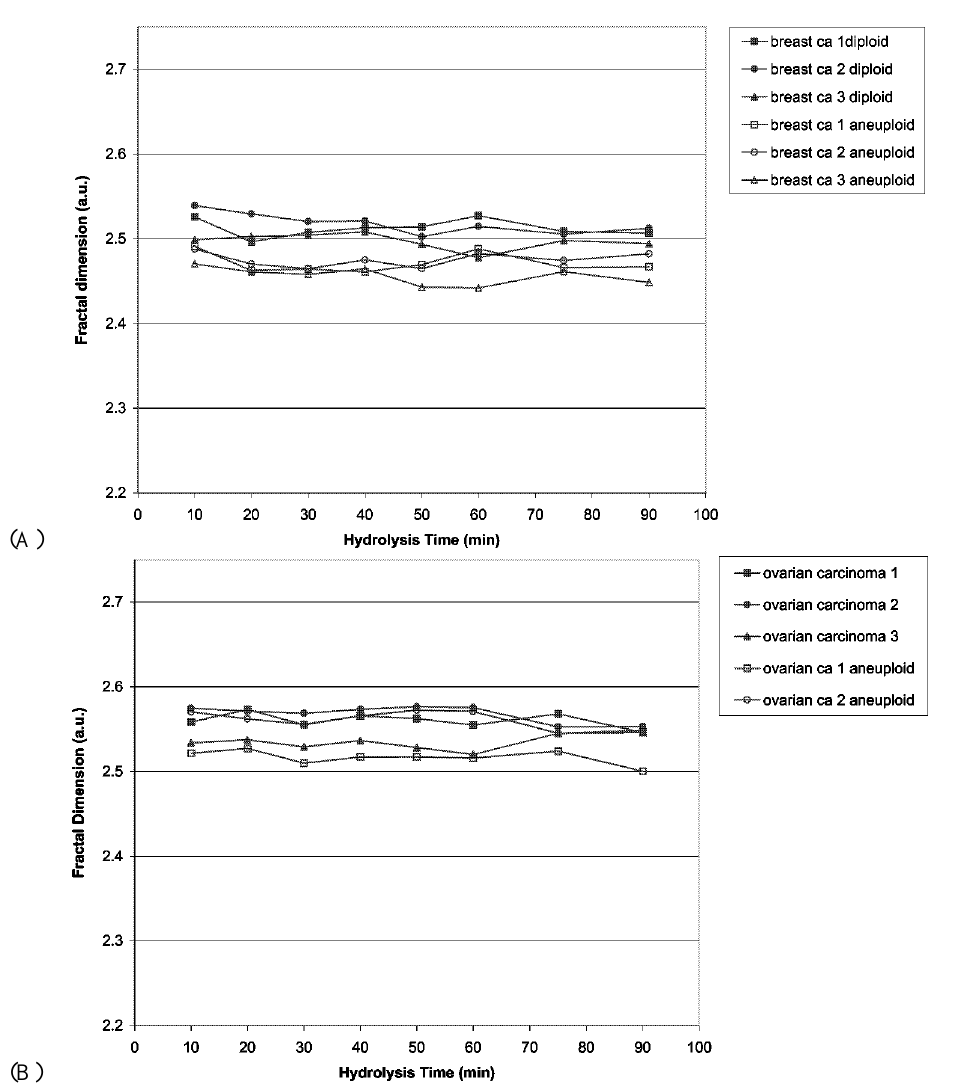
Fig. 4. (A) Hydrolysis profiles based on “fractal dimension” in diploid and aneuploid cell populations of breast carcinoma. (B) Hydrolysis profiles based on “fractal dimension” in diploid and aneuploid cell populations of ovarian serous